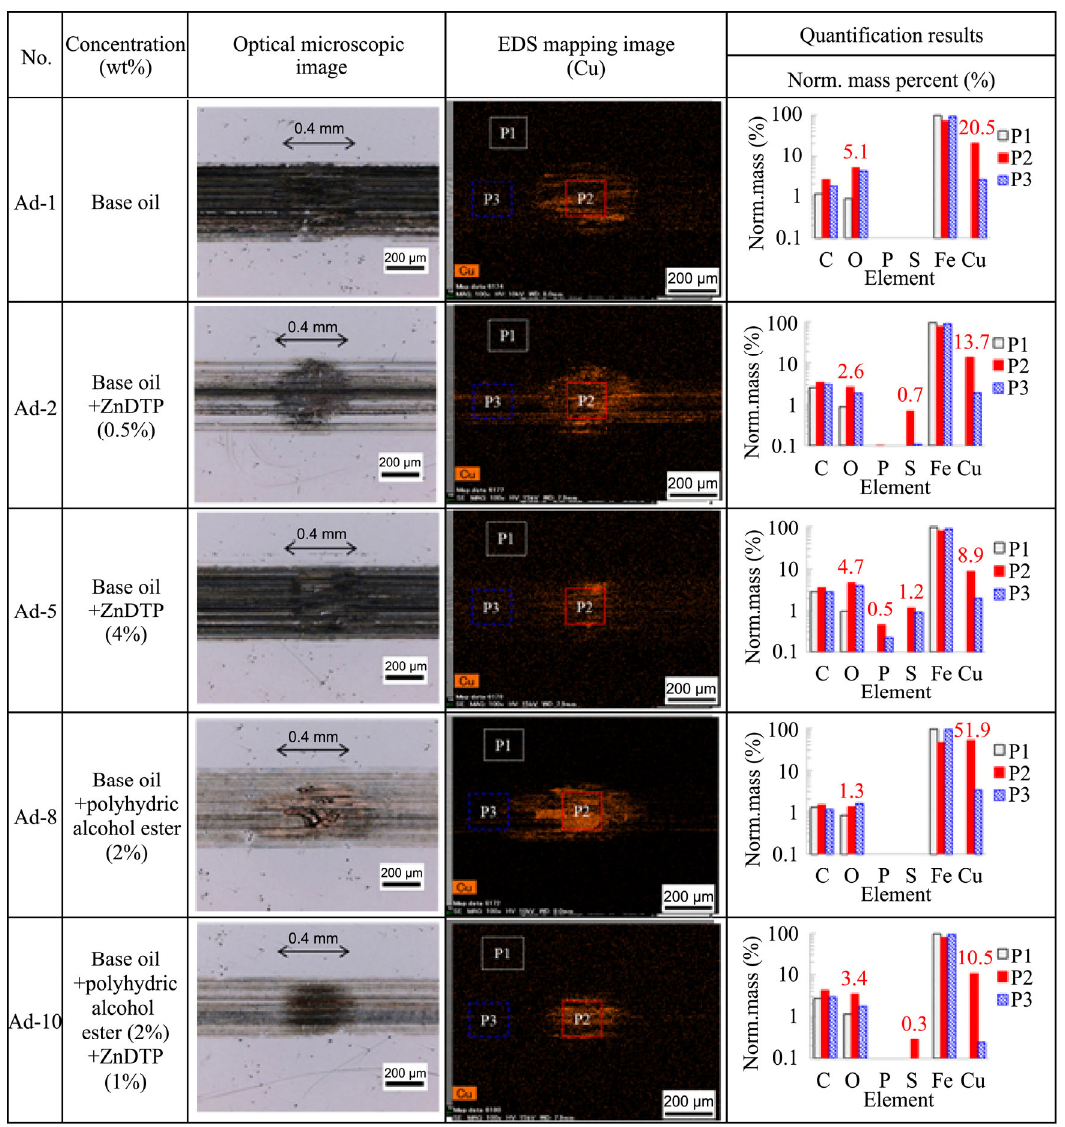
Fig. 11 Results of sliding surface observation and